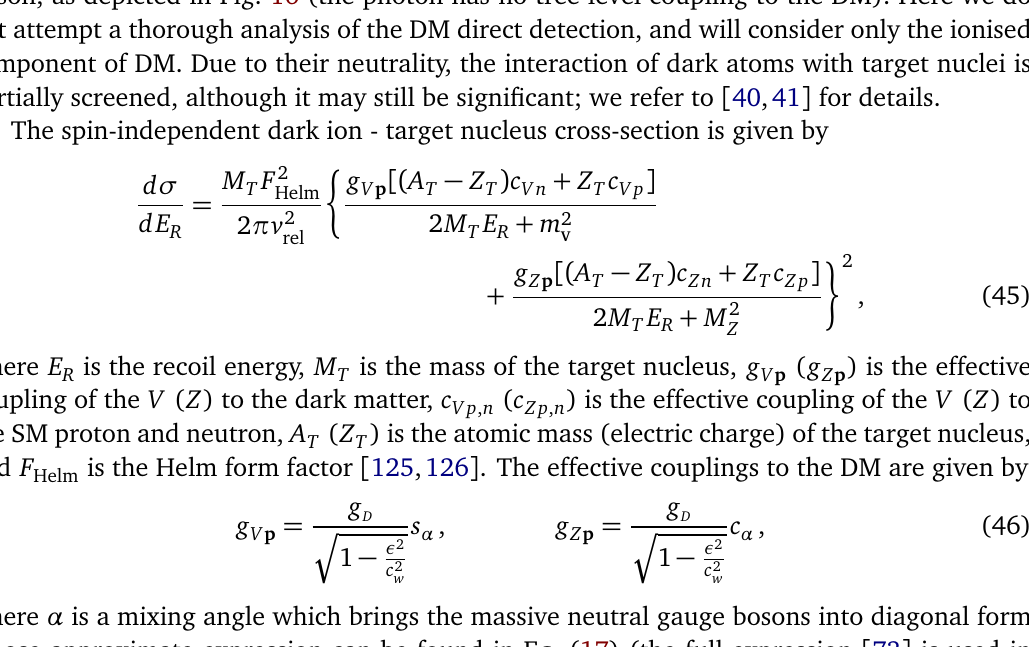
Figure 15: Running of the dark gauge coupling with m we are safe from a Landau pole for a few orders of magnitude above m relativistic DM annihilation cross section naively violates unitarity at α cating our perturbative expansion has broken down for such large values of α that presumably our perturbative results are no longer to be trusted already some- what below this